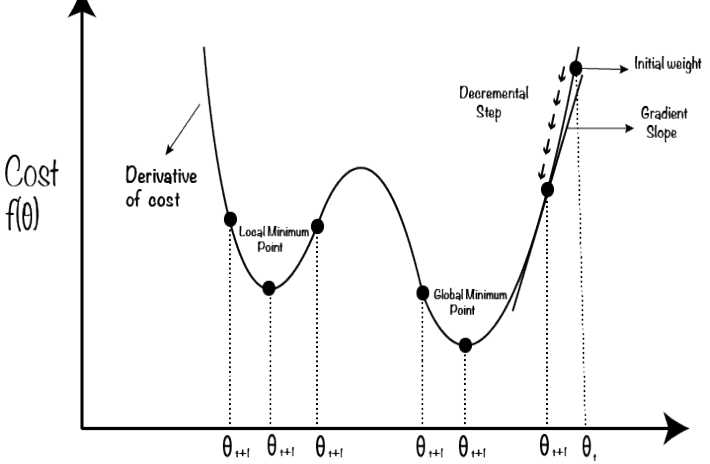
Figure 3. Local and global minimum